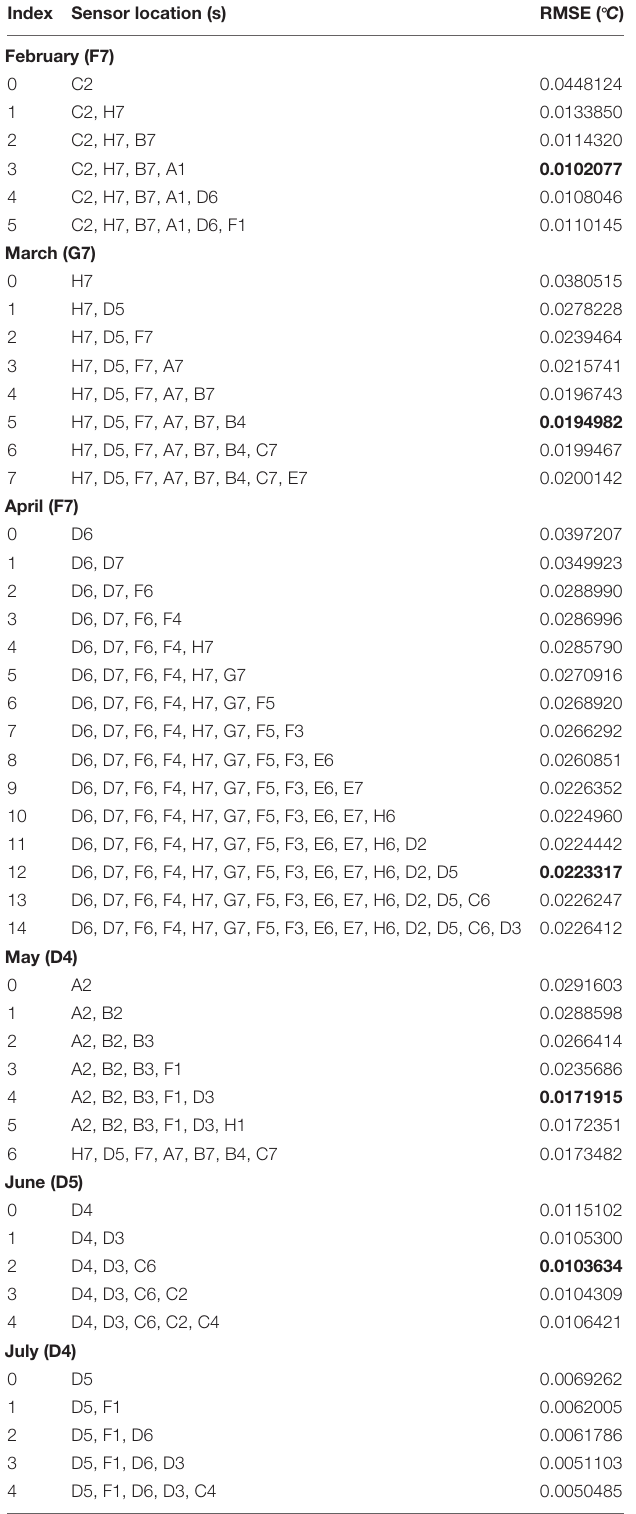
TABLE 2 | Performance of a sensor network in identifying the optimal number of sensors and placement for measuring greenhouse conditions across different months using temperature